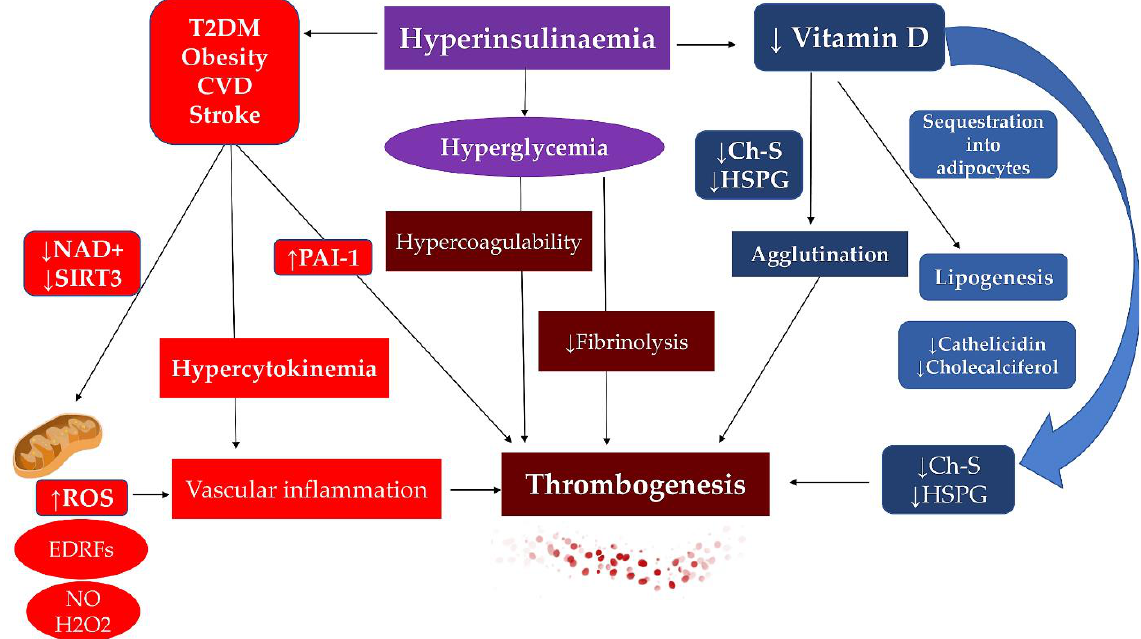
Figure 2. Endothelial dysfunction is orchestrated by various mechanisms: metabolites, molecular and inflammatory. Hyperinsulinemia, CVD and vitamin D have a strong impact on homeostatic equilibrium. Both hyperinsulinemia and hyperglycaemia generate states of increased coagulation and decreased fibrinolysis. By driving the development of CVD, diabetes mellitus and obesity, they contribute to the inflammatory substrate of cytokines. They increase the ROS production due to the damage in decreasing both NAD+ and reduced glutathione (GSH). A reduction in vitamin D due to sequestration into the adipocytes induces lipogenesis with de-creased level of cathelicidin and cholecalciferol, leading to decreased levels of ChS and HSPG, regulators of RBCs deformation and increased cells agglutination. These mechanisms are all responsible for thrombosis initiation. The vascular inflammation and decreasing levels of Ch-S and HSPG are represented with coloured backgrounds being the main actors of thrombogenesis trigger. In addition, thrombogenesis, the main effect, is outlined with a different colour too. Abbreviations: Ch-S: cholesterol sulfate, CVD, cardio- vascular disease; EDRFs, endothelium-derived relaxing factors, HSPG: heparan sulfate proteoglycans, NAD+: nicotinamide adenine dinucleotide, PAI-1 plasminogen activator inhibitor type 1, RBC, red blood cell; ROS: reactive oxygen species, T2DM: type 2 diabetes mellitus, SIRT3: sirtuin 3, TNF- α: tumour necrosis factor- α, IL -6: interleukin 6.